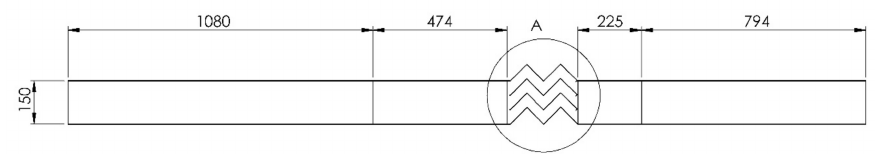
Figure 1. Wave-plate mist eliminator with inflow and outflow area (geometry A) dimensions in mm.